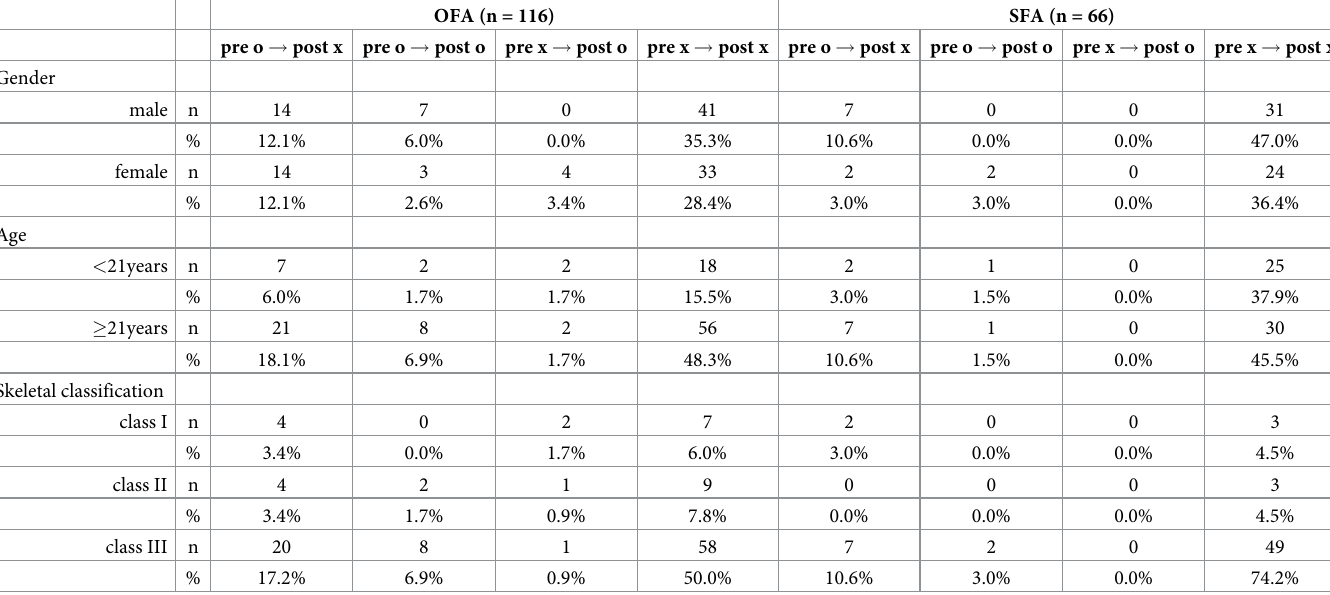
Table 5. Changes in TMJ clicking before the start of the surgical-orthodontic treatment and after surgery. OFA (n = 116) SFA (n = 66)